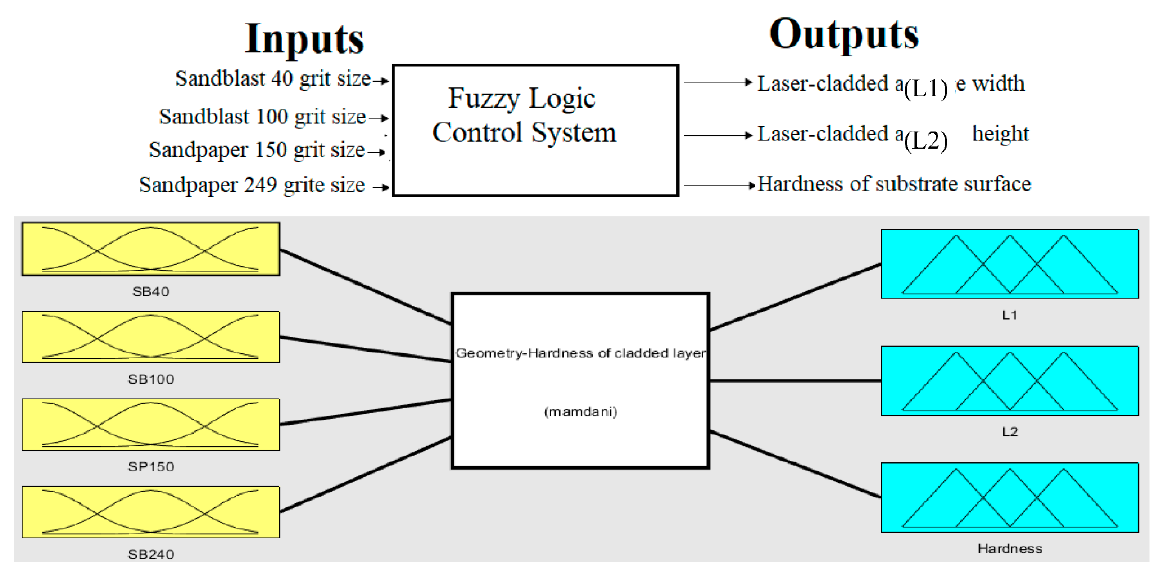
Figure 6. Geometry-hardness of laser cladded layer Fuzzy Logic Control System.